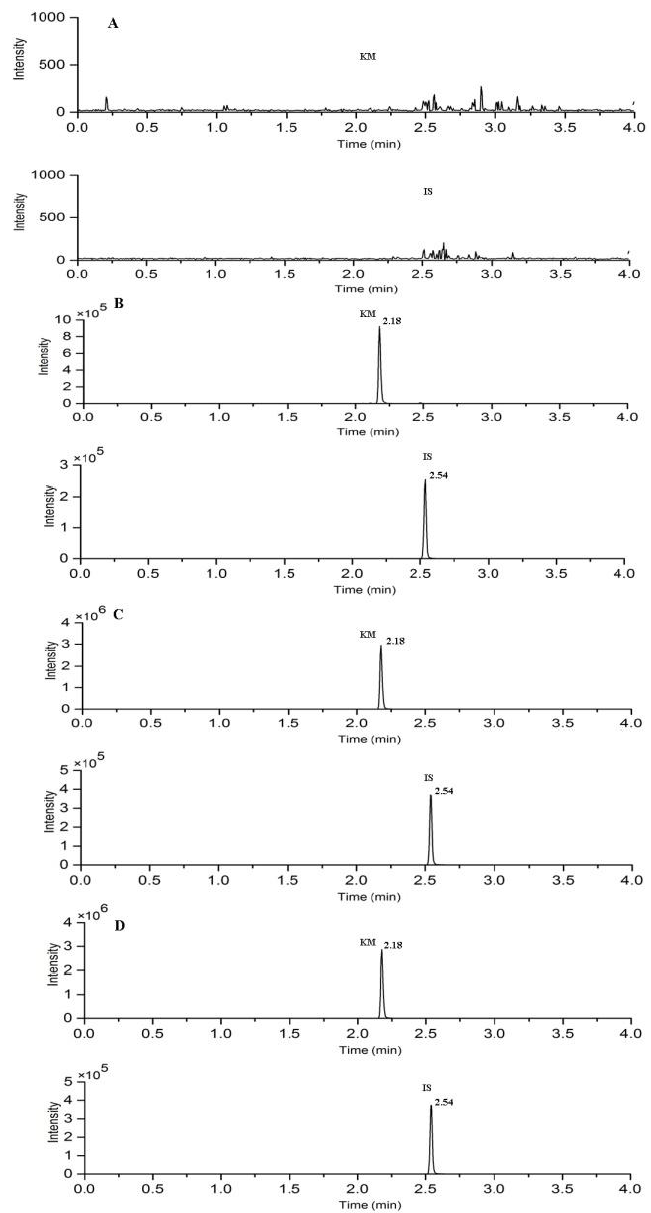
Figure 2. Typical chromatograms of ( A ) blank rat plasma; ( B ) blank rat plasma spiked with KM and IS; ( C ) rat plasma sample at 20 min; and, ( D ) liver sample at 30 min after a single intravenous dose of 10 mg/kg KM. Representative MRM chromatograms of KM and